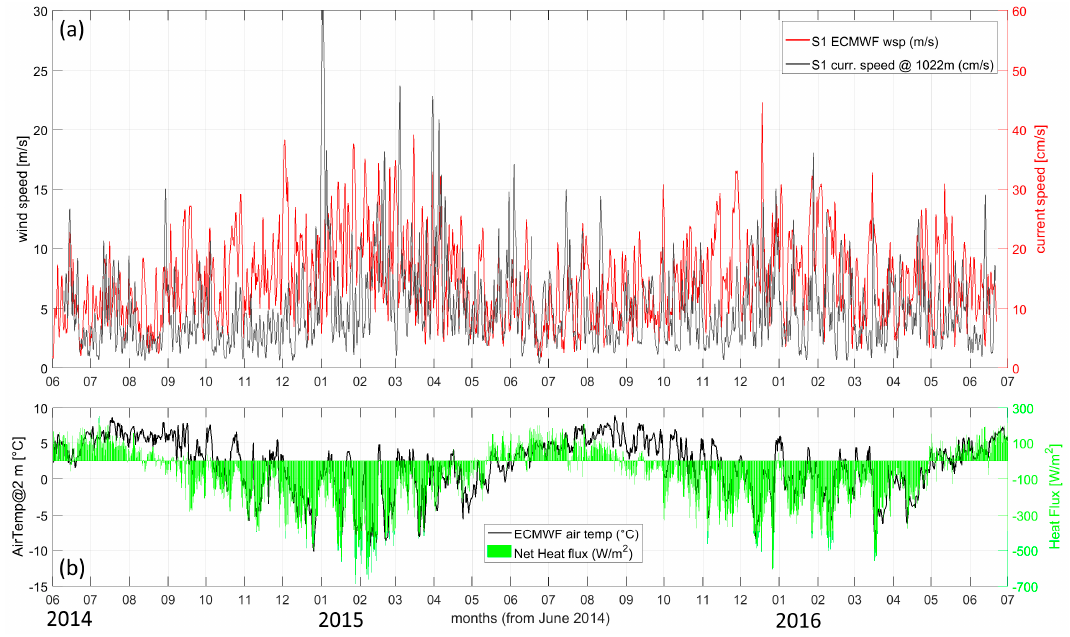
Figure 9. ECMWF wind speed (m s − 1 ) and deep current (cm s − 1 ) time series at S1 ( a ). Data are smoothed with a daily moving average. Air temperature ( ◦ C) and net heat fluxes (W m − 2 ) at the air-sea interface obtained from ECMWF ERA-Interim dataset ( b ).